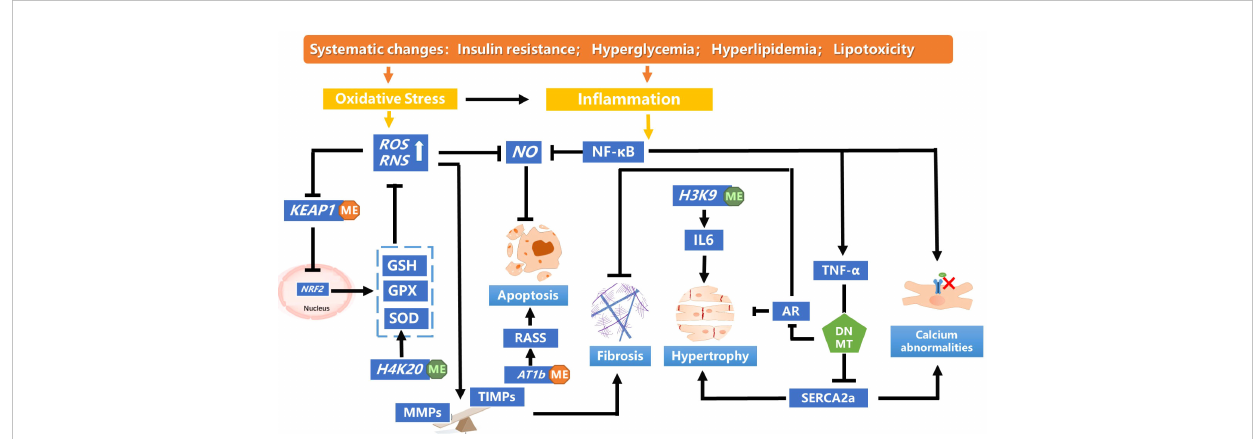
FIGURE 2 A summary of the DNA methylation and histone modi fi cation pathways leading to pathological cardiac dysfunction in diabetic cardiomyopathy. In diabetics, insulin resistance mediates systemic hyperglycemia, hyperlipidemia and lipotoxicity, inducing oxidative stress and in fl ammation., Hypomethylation of KEAP1 promoter was observed in patients with DCM, which maintains the low transcriptional activity of NRF2 by targeting proteases for degradation. The decreased NRF2 antioxidant system changes redox homeostasis and leads to aggravated oxidative stress. Monomethylating H4K20 reduces the accumulation of ROS and restores NO levels, which alleviates oxidative stress. Massive production of ROS disturbs the balance between MMPs and TIMPs, inducing myocardial fi brosis and cardiac remodeling. TNF- a increases DNMT levels, which enhanced methylation of SERCA2a promoter, thereby decreasing SERCA2a expression. SERCA2a mediates the heart relaxation by transferring Ca 2+ from the cells into the sarcoplasmic reticulum. Downregulation of SERCA2a expression cause myocardial hypertrophy. DNMT could enhanced cardiac fi broblast autophagy in diabetic cardiac fi brosis by inhibiting AR axis. Decreased H3K9me3 level in the IL-6 promoter increased its mRNA level, which affect the pathology of myocardial fi brosis and cardiomyocyte hypertrophy. IL, interleukin; NF- k B, nuclear factor-enhanced light chain activator of B cells; NO, nitric oxide; Reactive oxygen species; RAAS, renin – angiotensin – aldosterone system; TNF- a ,tumour necrosis